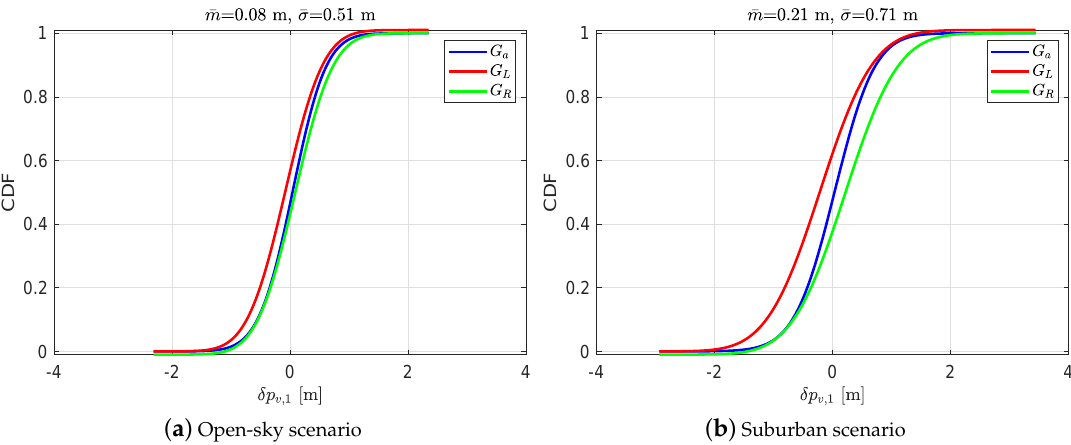
Figure 6. Empirical and overbounding cumulative distribution functions (CDFs) for the weighted between-receiver code residuals on L1 δ p v ,1 in: ( a ) the open-sky scenario and ( b ) the suburban scenario. The overbounding mean and standard deviations for the weighted between-receiver phase and code residuals are given in Table 4 for all observation types, for the open and suburban scenarios.